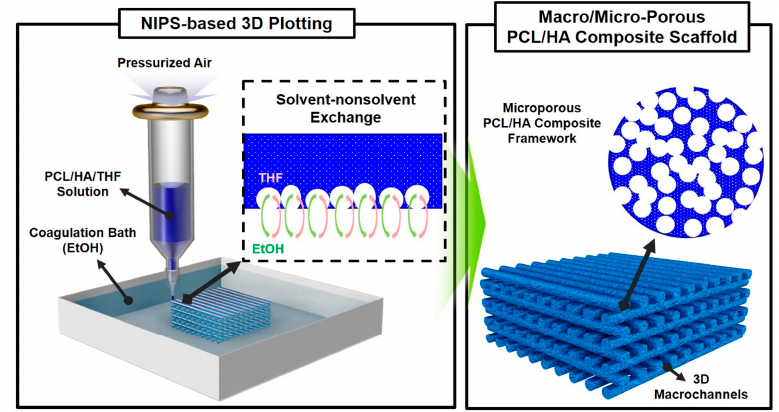
Figure 1. Schematic diagram of the non-solvent induced phase separation (NIPS)-based 3D plotting technique for the production of poly( ε -caprolactone)(PCL)/hydroxyapatite (HA) scaffolds with a controlled macro/micro-porous structure.